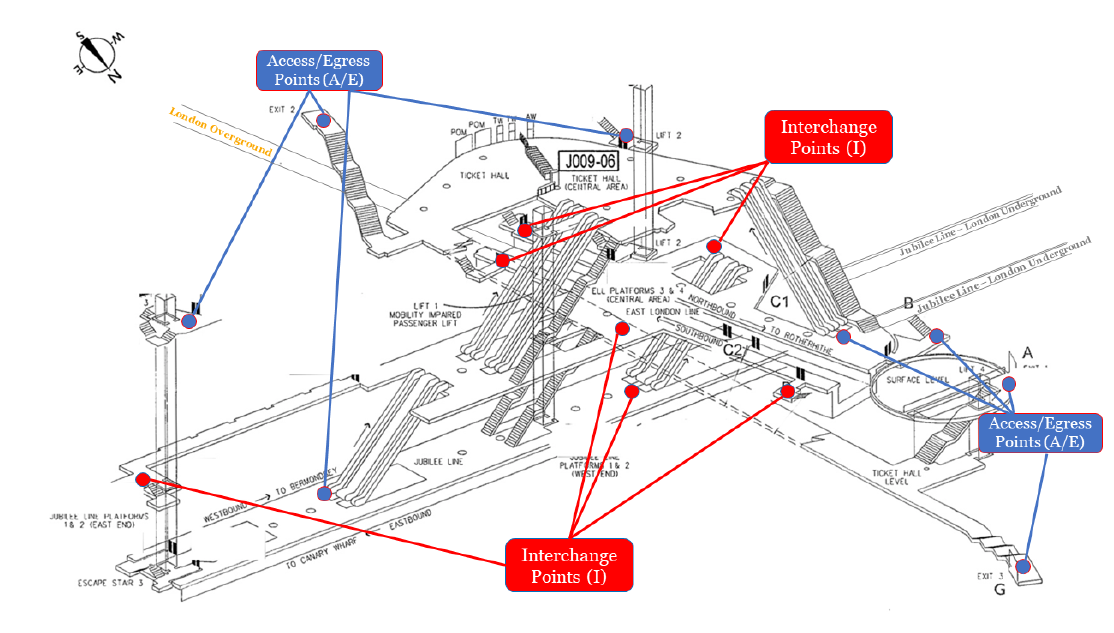
Figure 3. Test scenario